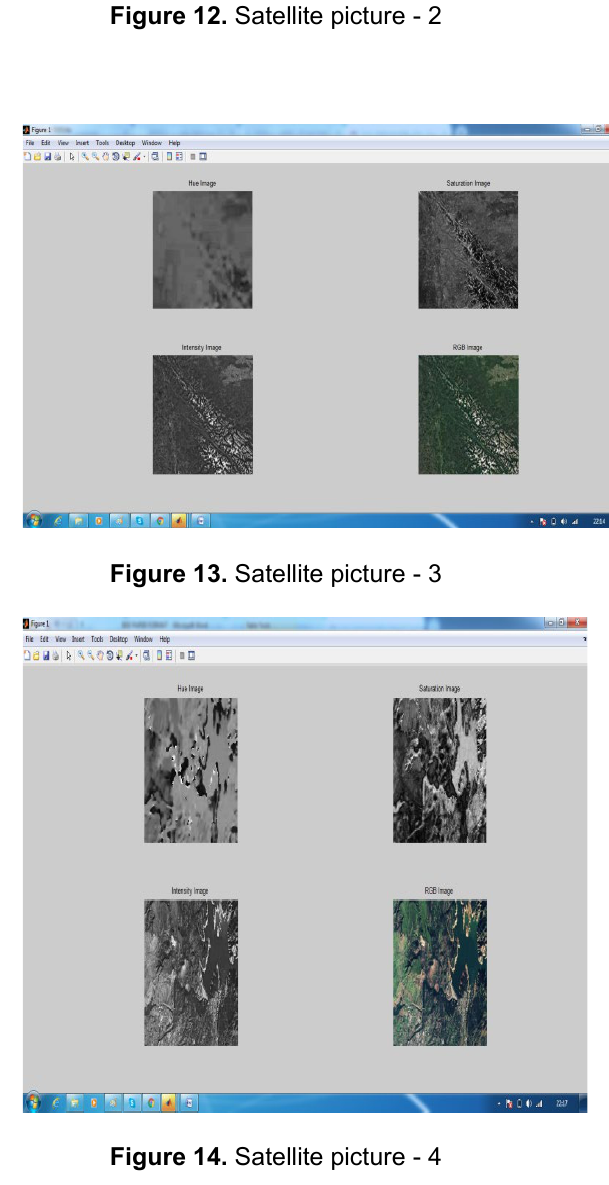
Figure 14. Satellite picture -